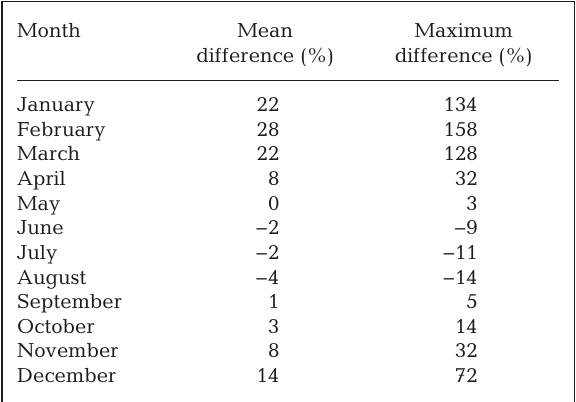
Table 4. Difference between salmon louse hatch rate where temperature from 3 m depth (Estimate 1) and temperature from where we assume that farmed salmon reside (Estimate 4) is used. Positive (negative) values show when Estimate 4 is greater (less) than Estimate 1